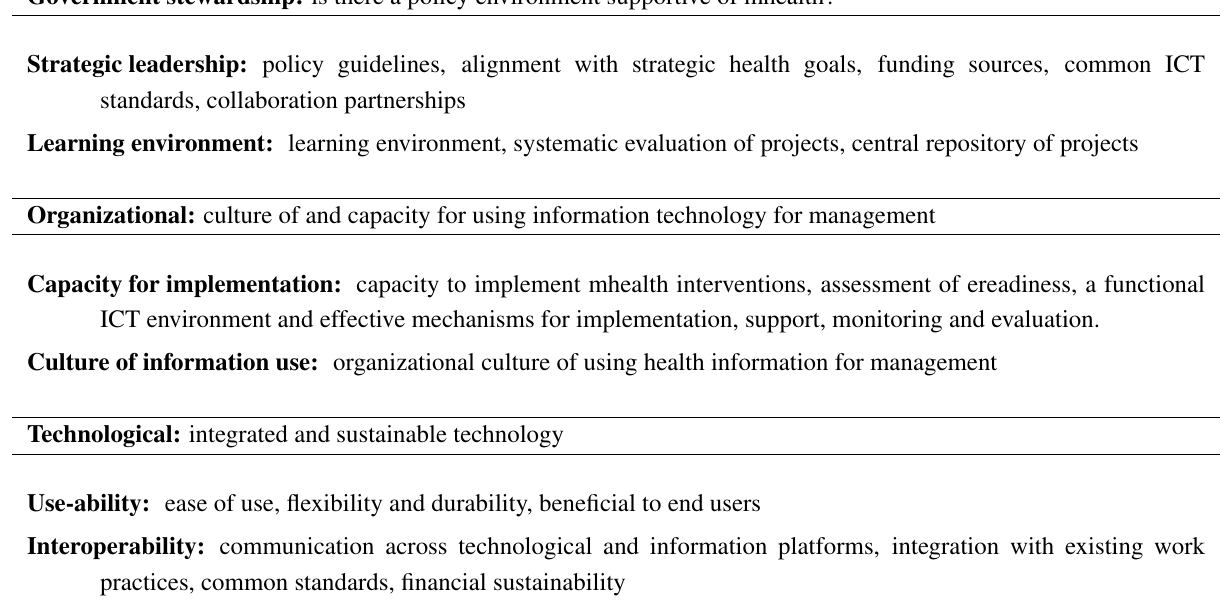
Table 4. Adaptation of the Framework for Assessing the Health System Challenges